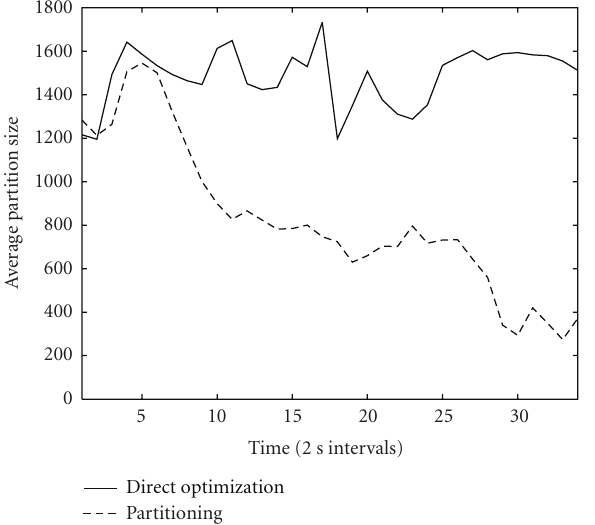
Figure 19: Comparison of sample mean exploration partition size over simulation time between state-of-the-art direct distribution optimization and partition learning classification path planning approaches.